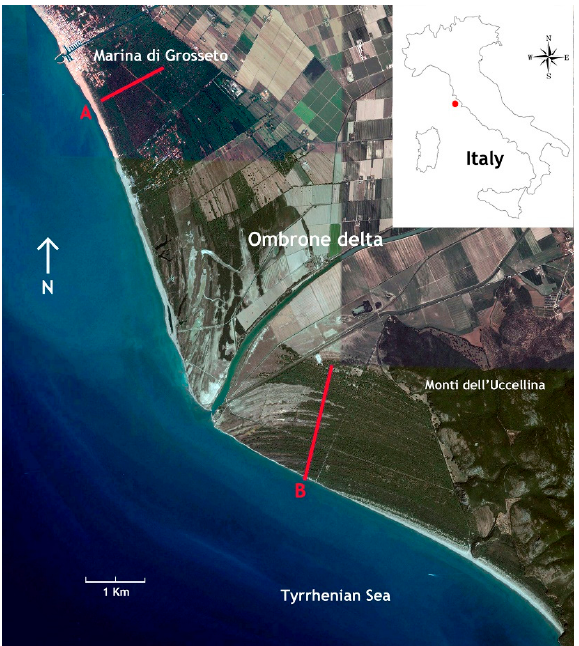
Figure 1. The Ombrone River delta and the position of the two topographic profiles drawn in figure 3 (Google Earth